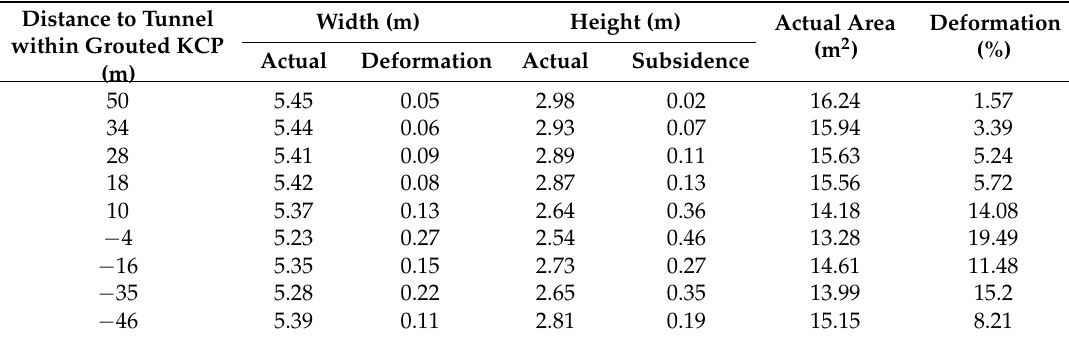
Figure 6. The fracture of roadway roof and floor (picture from 24 October 2013). Table 1. Deformation of overlying strata at site region.